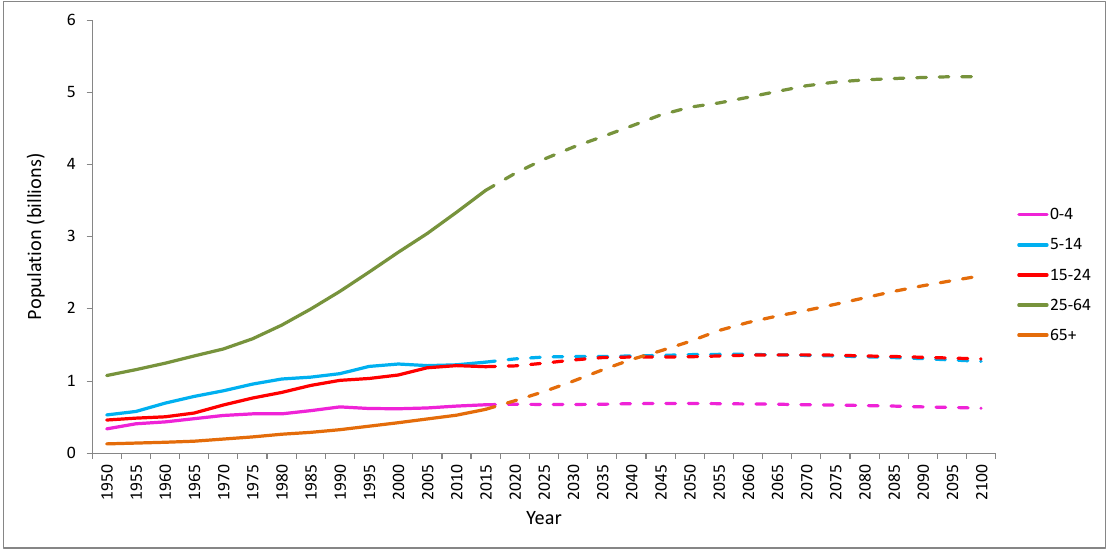
Figure 1. People aged 65+ years old make up the fastest-growing age group worldwide. Data from [3].